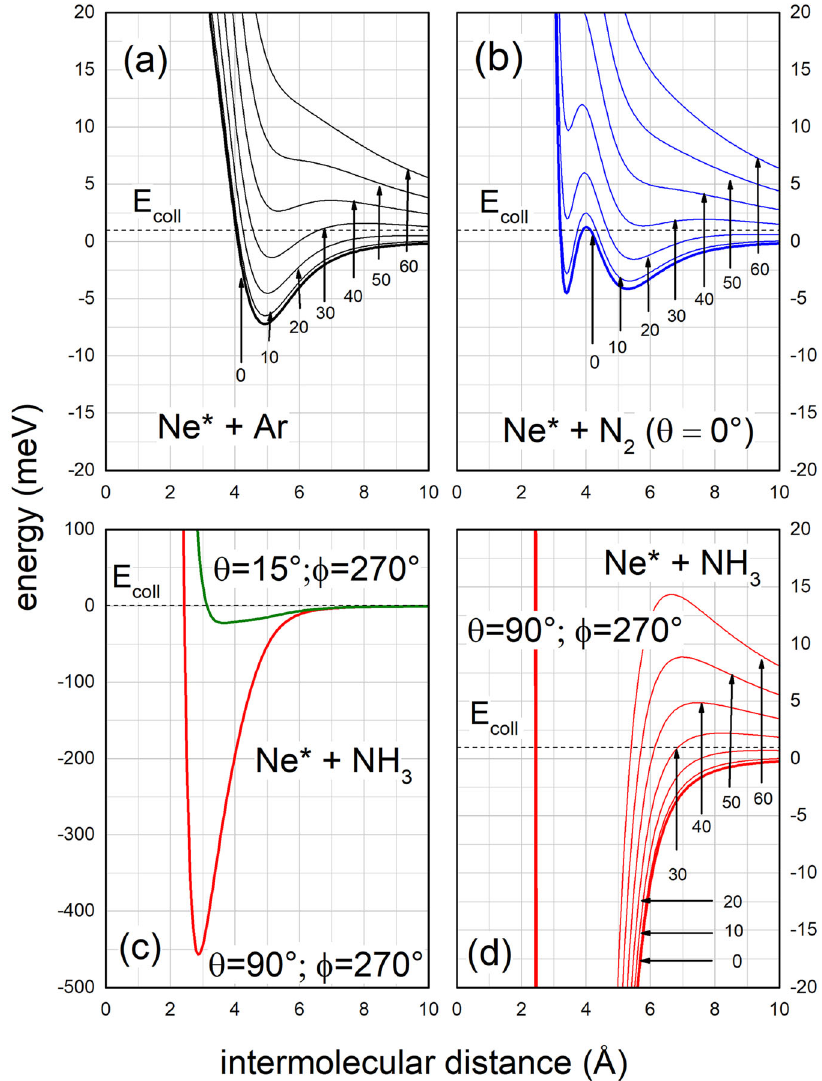
Fig. 2 Interaction potentials controlling Ne * + Ar, N 2 , NH 3 investigated CHEMI. Dependence on the intermolecular distance R of the total potential energy V t given as sum of the real component V and of the centrifugal contribution V C , de fi ned as V C ¼ _ 2 system. θ and ϕ are the polar orientation angles of the molecule, as de fi ned in Fig. 1 for NH 3 7,8,34,35 . The E coll value has been fi xed to 1.0 meV and represented by a horizontal dashed line. For both Ne * -Ar ( a ) and Ne * -N 2 ( b ) the V component is that asymptotically correlating with Ne( 3 P 0 ) fi ne level of the reagent 25,34 , while for Ne * -NH 3 ( c , d ), the plotted V components account for the formation of the precursor state in two basic geometries, opening different CHEMI channels 35